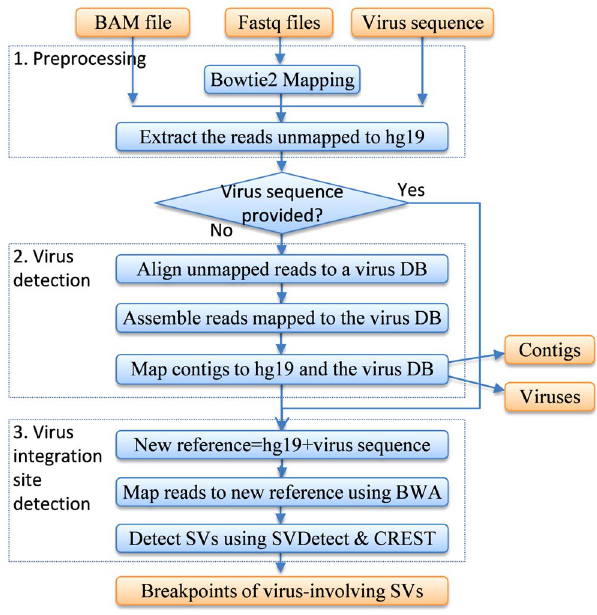
Figure 1. VirusFinder’s pipeline to detect viruses and their integration sites in next generation sequencing (NGS) data. VirusFinder overall follows a three-step procedure: (1) preprocessing, (2) virus detection, and (3) virus integration site detection. The current version of VirusFinder (release 1.0) uses UCSC hg19 (http://hgdownload. cse.ucsc.edu/downloads.html # human) as reference human genome. DB: database. SVs: structural variants (especially inter-chromosomal